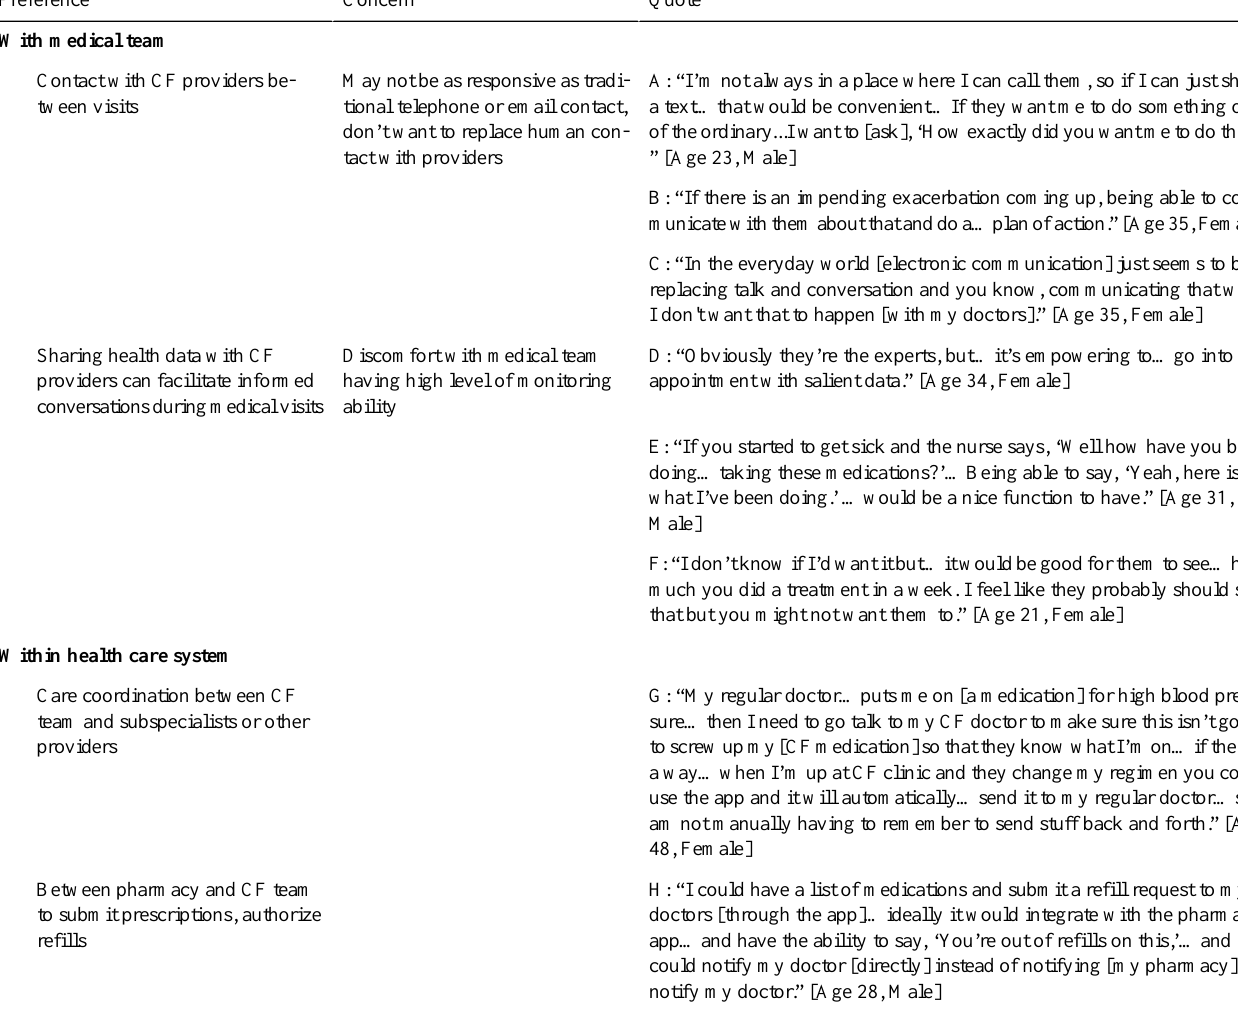
Table 4. Participant preferences, concerns, and illustrative quotes regarding Communication